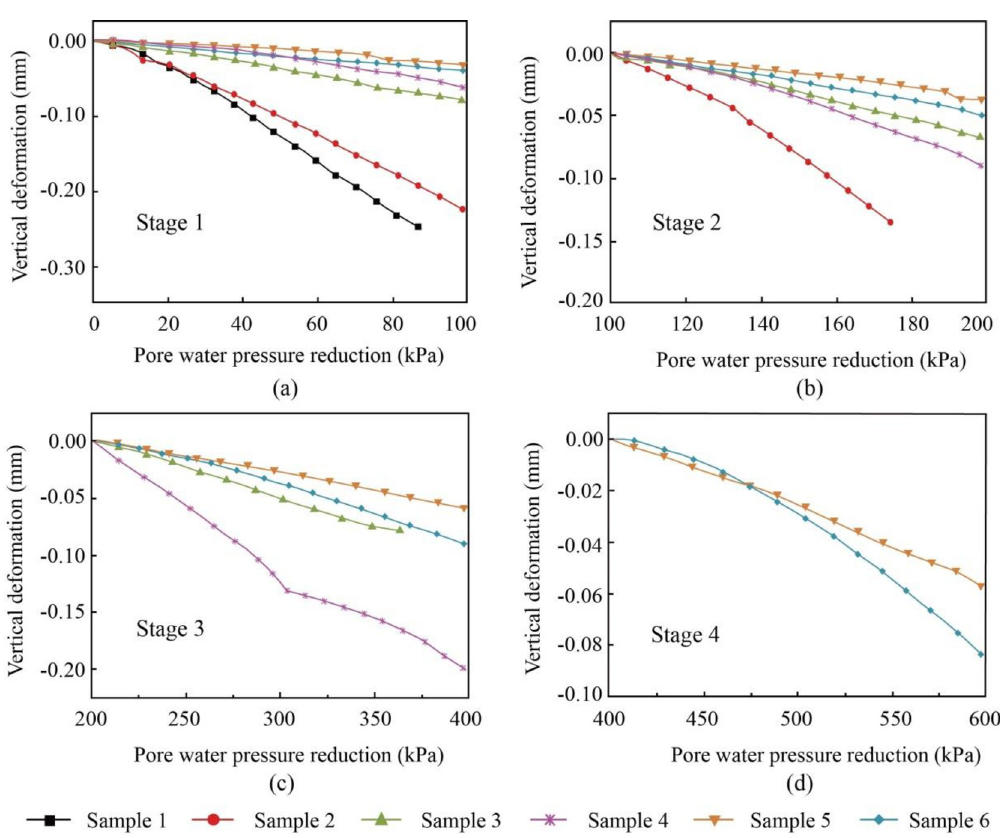
Fig 6. Variations in vertical deformation with changing pore water pressure in Stage 1 (a), Stage 2 (b), Stage 3 (c) and Stage 4 (d). https://doi.org/10.1371/journal.pone.0232828.g006 Sample 1 presents the largest deformation when the pressure decreases from 88 to 0 kPa, fol- lowed by the thicker Sample 2, with a slightly smaller deformation than Sample 1. The defor- mations of these samples are both of an order of magnitude greater than those of the other 4 samples. For Sample 1, the unit rate of vertical deformation (deformation rate), defined as the amount of vertical deformation per unit pore water pressure for 1-meter-high samples, is approximately 0.1134 mm/kPa, as shown in Table 4. The deformation rate decreases with